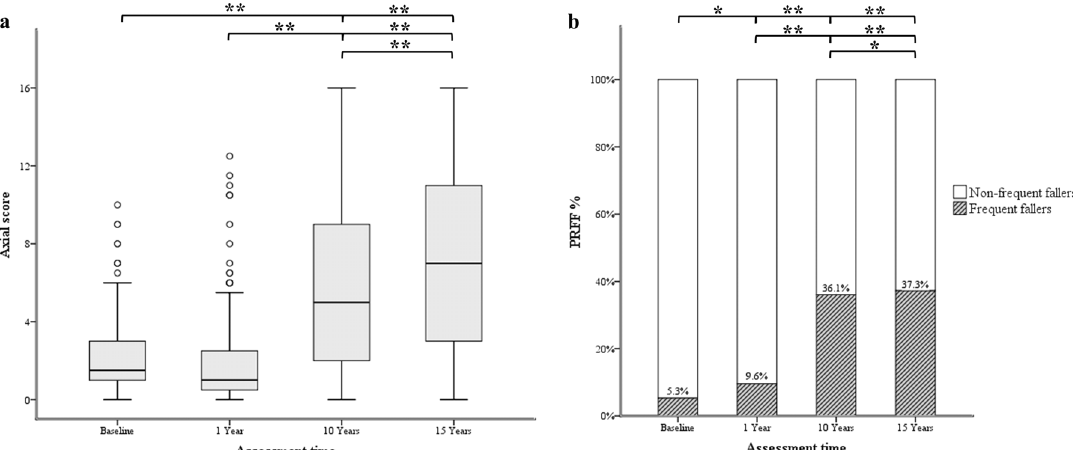
Fig. 1 Evolution of axial scores and prevalence rate of frequent-fallers in people with Parkinson ’ s disease and subthalamic deep brain stimulation. Longitudinal values of axial scores are displayed through box plots ( a ). The central values within boxes correspond to the median (50th percentile, or Q2), whereas the range between the lower (25th percentile, or Q1) and upper (75th percentile, or Q3) bounds of the boxes re fl ects the interquartile range (IQR). Whiskers include scores outside IQR, whereas ends re fl ect maximum (Q3 + 1.5 × IQR) and minimum values (Q1 × IQR). Spots are outliers above the maximum values of whiskers. Longitudinal prevalence rate of frequent-fallers (PRFF%) is expressed as a percentage through histograms ( b ). Asterisks indicate the main differences among groups (** p < 0.001, * p < 0.05).